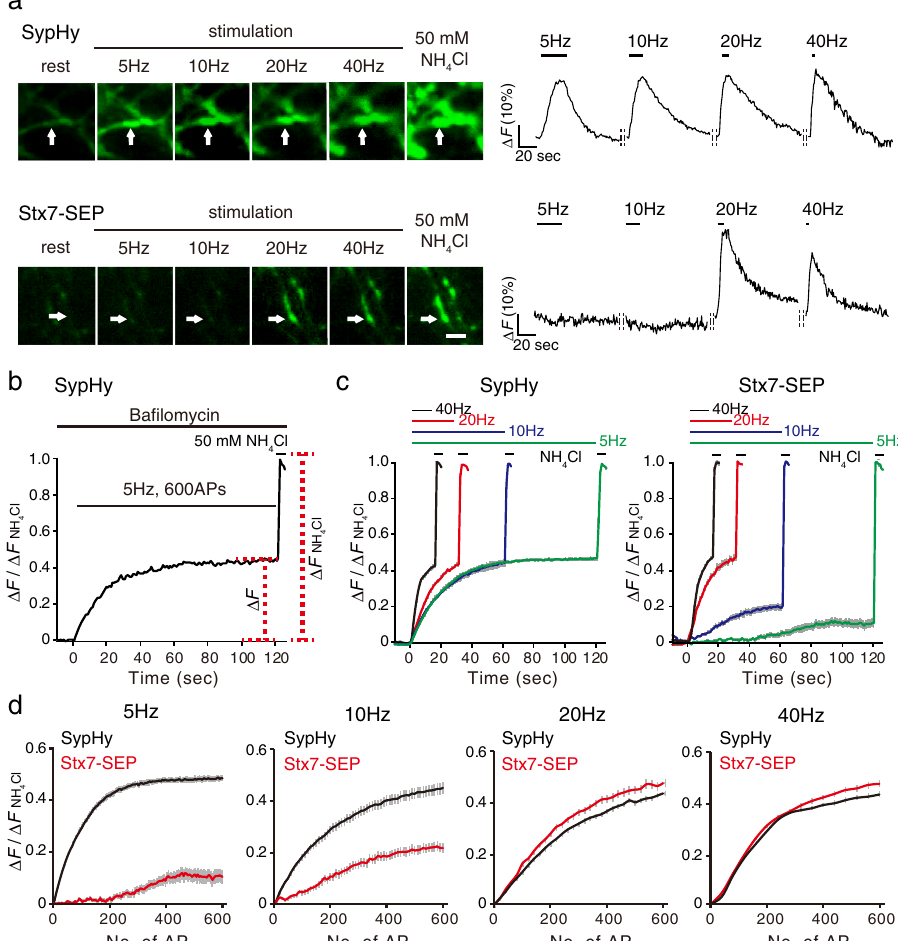
Fig. 2 Stx7-SEP-vesicles recycle preferentially upon HFS. a Stimulus-frequency-dependent responses of Stx7-SEP in comparison to SypHy. Neurons expressing respective SEP fusion constructs were subjected to sequential stimulation ranging from 5 to 40 Hz (200 APs) at 5 min intervals. Left images are representative images of SypHy (top), Stx7-SEP (bottom) at rest, at the end of stimulation at 5, 10, 20, and 40 Hz, and upon application of NH 4 Cl at the end of recordings. Right traces show representative traces of each SEP- fl uorescence change in boutons, indicated by arrows. Data were normalized to fl uorescence signals upon application of NH 4 Cl at the end of recordings. b Experimental scheme to estimate the kinetics of exocytosis, as well as sizes of total recycling SV pools. Neurons were pretreated with 2 µ M ba fi lomycin A1 for 60 s and then stimulated with 600 APs at different stimulation frequencies. After cessation of stimulation, 50 mM NH 4 Cl was applied and fl uorescence during NH 4 Cl application was used to normalized fl uorescence signals at individual boutons. c Recycling pool of SypHy and Stx7-SEP. Cells expressing SypHy (left) and Stx7-SEP (right) were stimulated with 600 APs at different frequencies (5, 10, 20, and 40 Hz). d Replots of SypHy (black) and Stx7-SEP (red) responses of the results in ( c ) as a function of stimulus numbers (No. of